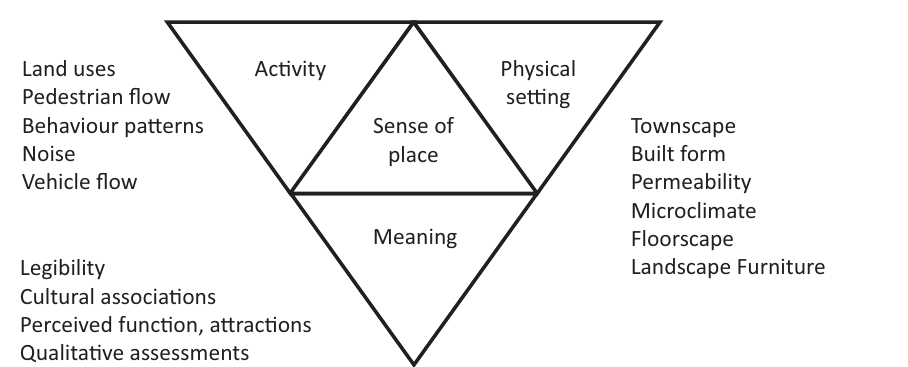
Figure 4. Components of sense of place (Punter, 1991, p.